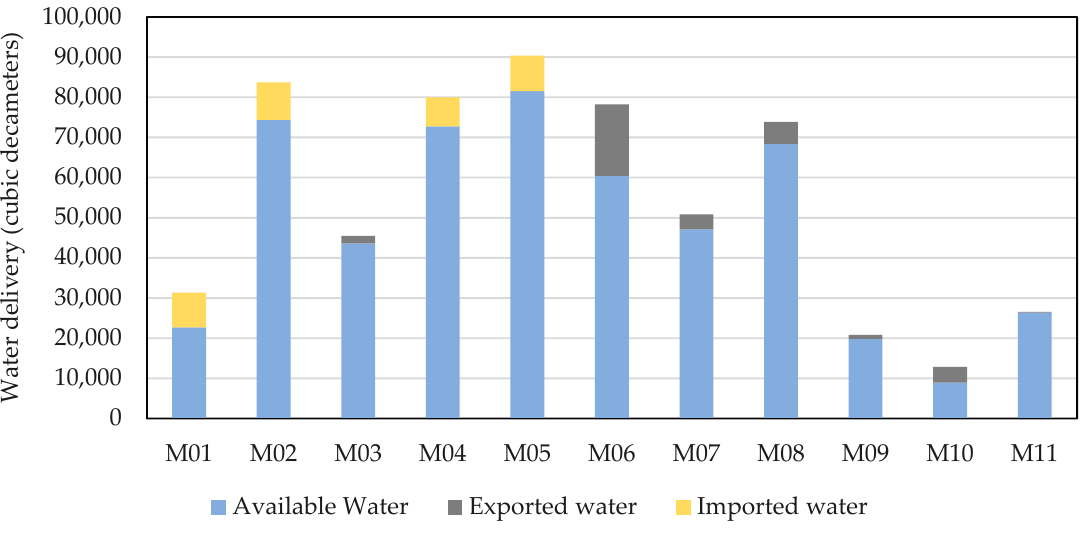
Figure 4. Breakdown of water use under 50% shortage scenario with water market.